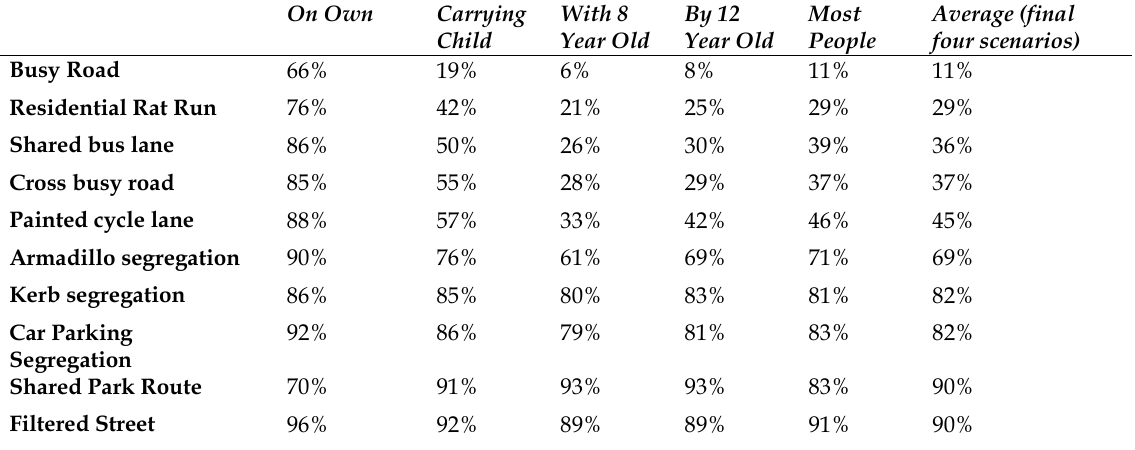
Table 2. Preferences by situation and